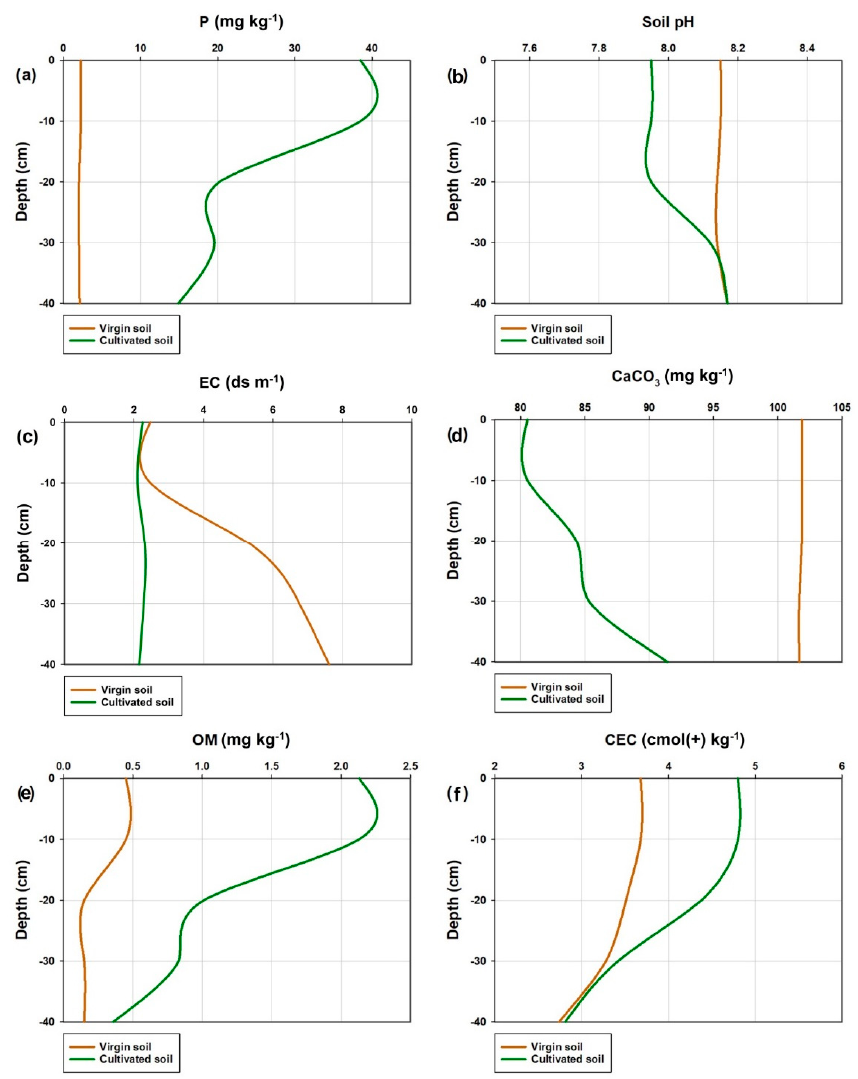
Figure 4. Vertical distributions of virgin and cultivated soil properties at the investigated depths: ( a ) available phosphorus (P); ( b ) soil pH; ( c ) soil electrical conductivity (EC); ( d ) CaCO 3 content; ( e ) organic matter (OM); ( f ) cation exchange capacity (CEC).